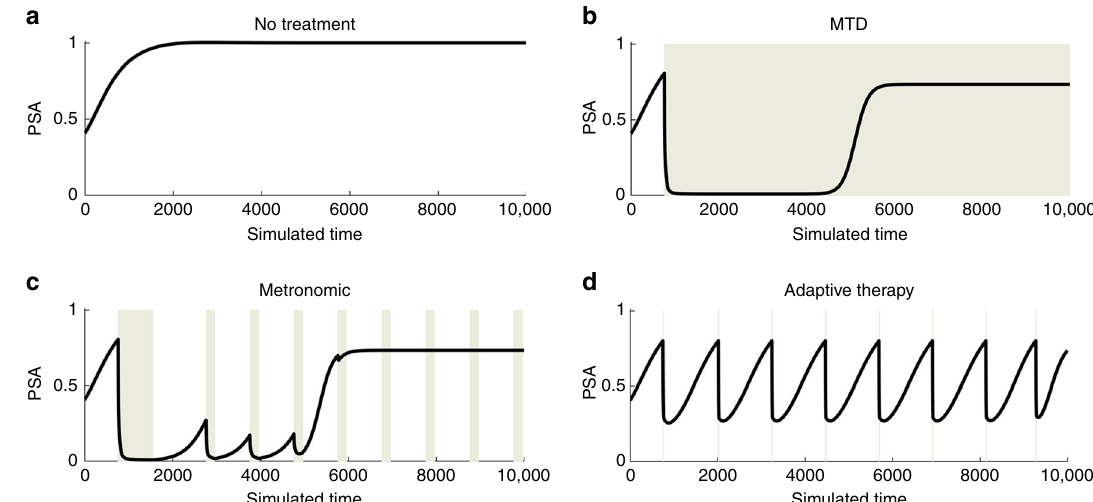
Fig. 3 Computer simulations of PSA under varying treatment conditions. The gray background indicates administration of abiraterone in Patient #1. a demonstrates the PSA dynamics if no treatment was administered. b shows the classic PSA dynamics of maximal tolerated dose MTD, where a large response is maintained until PSA progression. c show the PSA dynamics for a metronomic therapy where treatment is not synchronized to patient-speci fi c PSA dynamics. d shows the PSA dynamics of the clinical trial protocol, where PSA decreases to 50% of the baseline PSA and is allowed to return back to baseline before another dose of abiraterone is